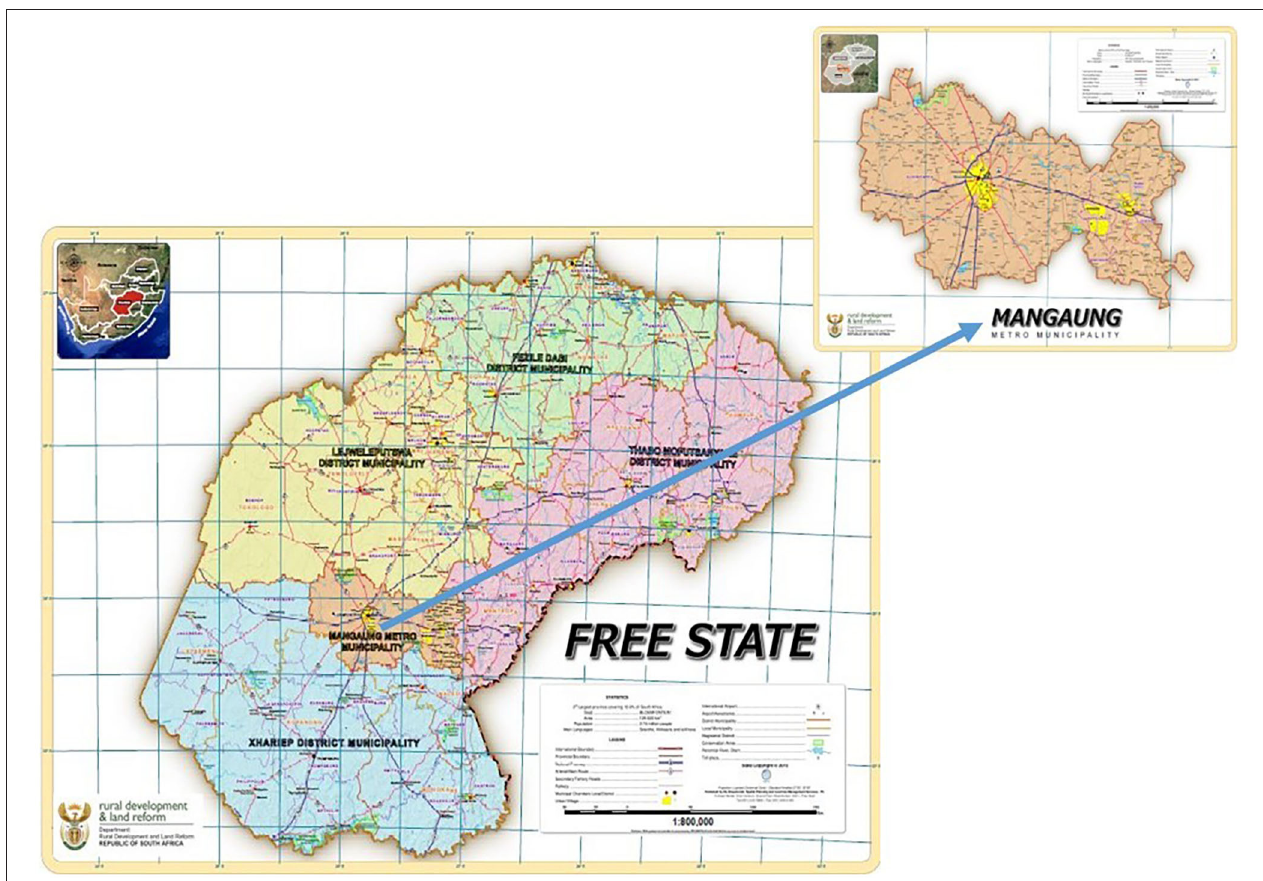
FIGURE 1 | The Mangaung metropolitan municipality within the free state